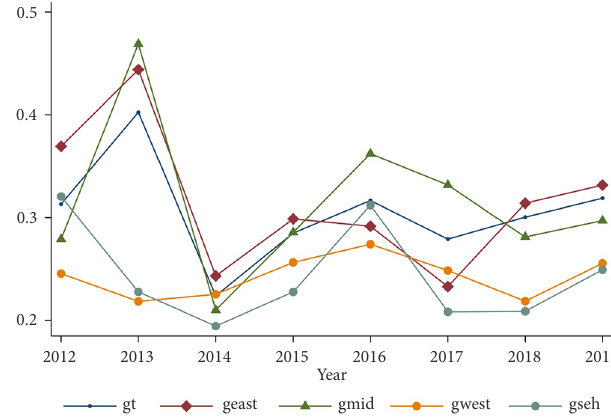
Figure 4. The Gini coefficient trends of the urban resilience in